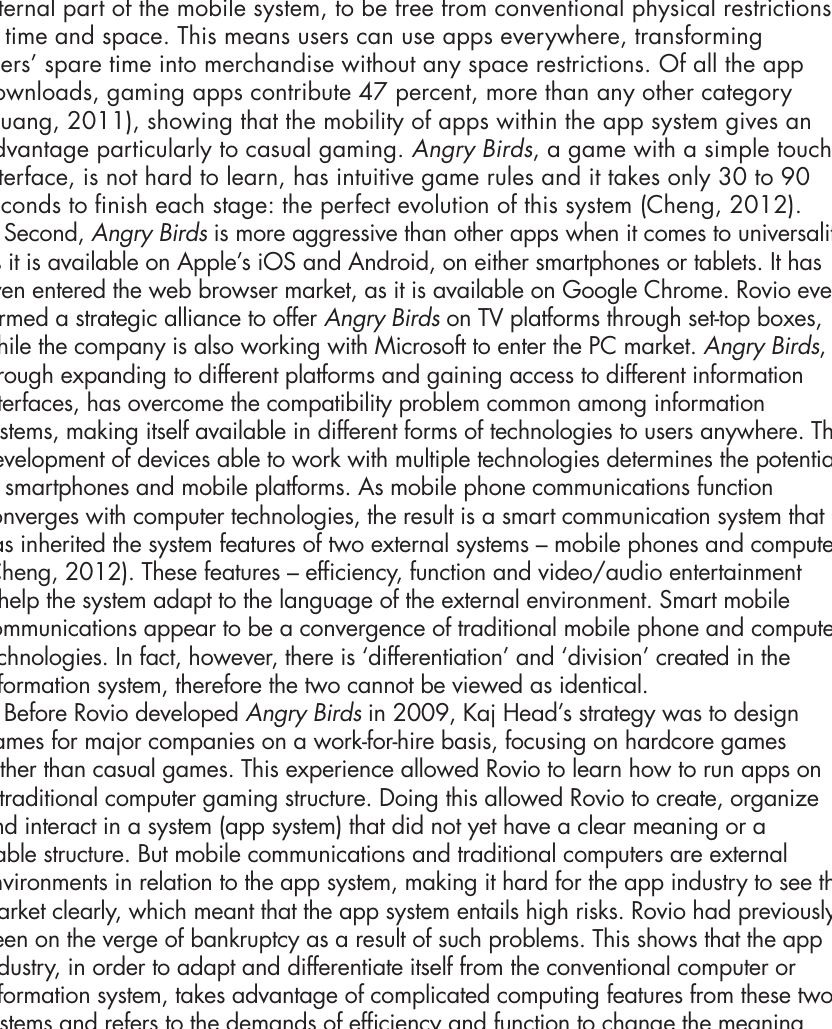
Source: Kingsley-Hughes